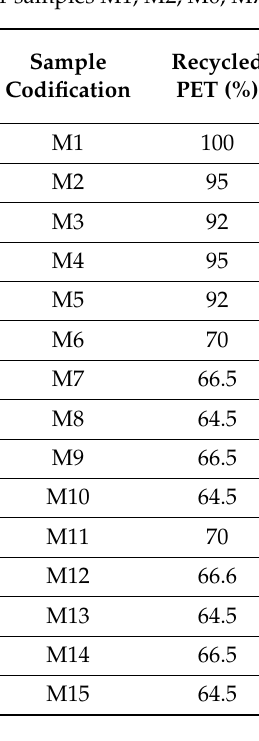
Table 1. Composition and hydrostatic density of recycled PET hybrid substrates (preliminary results